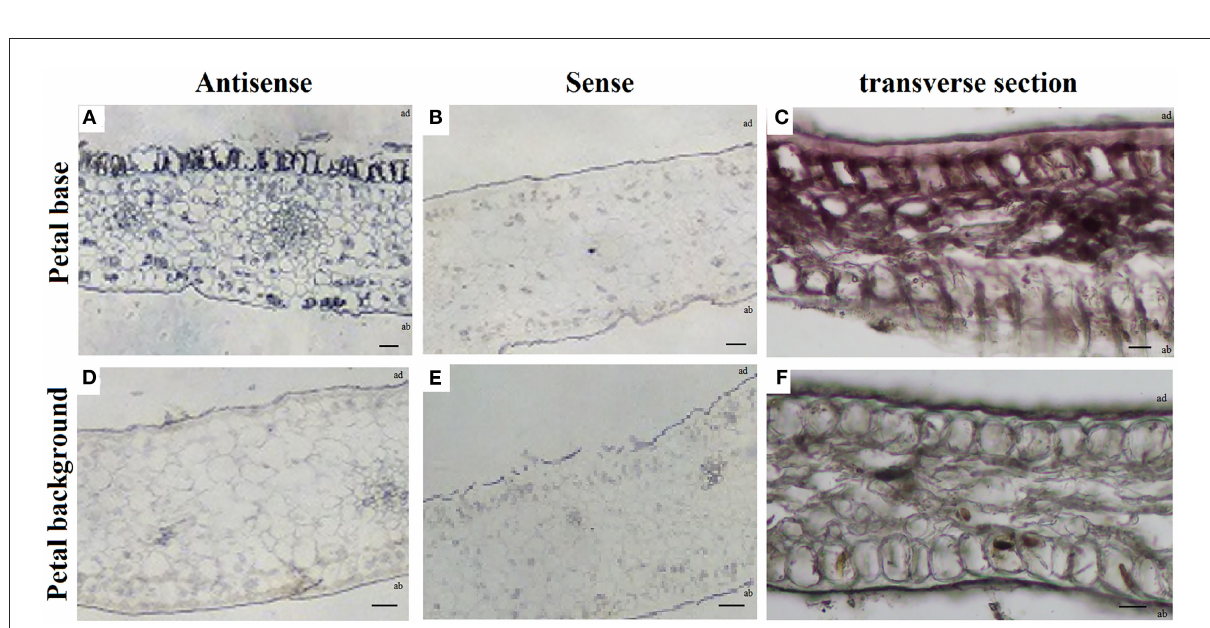
FIGURE3 RNA in situ hybridization of PrMYB5 transcripts in the stage 4 petals of P. rockii . (A,B) Transverse sections of the petal base of P. rockii were hybridized with antisense or sense RNA probes of PrMYB5 . (C) Transverse section of the petal base of P. rockii . (D,E) Transverse sections of the petal background of P. rockii were hybridized with antisense or sense RNA probes of PrMYB5 . (F) Transverse sections of the petal background of P. rockii . ab indicates Abaxial surface; ad indicates Adaxial surfaces. Bars = 100mm.